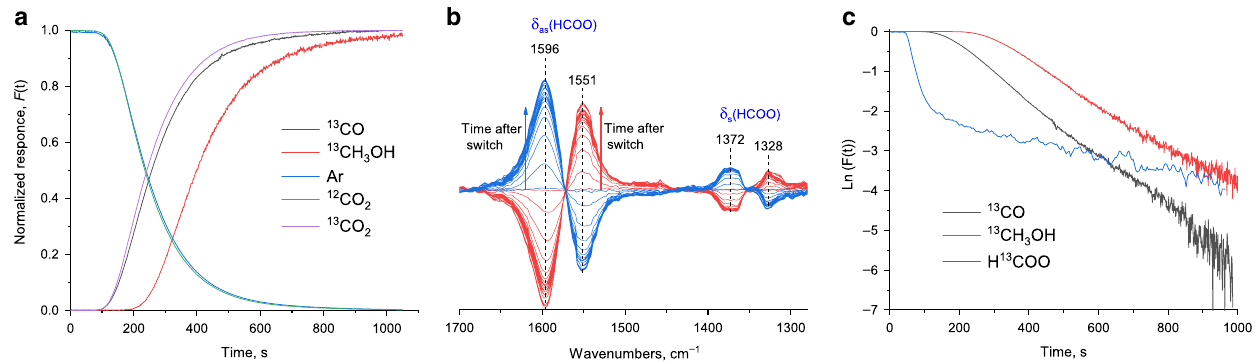
Fig. 1 Results of SSITKA-FTIR experiment. a Normalized isotopic transient response curves following the switch from 12 CO 2 /H 2 to 13 CO 2 /H 2 mixture with a total fl ow of 25 cm 3 min − 1 , H 2 /CO 2 molar ratio of 3 at 533 K and 15 bar during the reaction over CZA catalyst. b Time-resolved in situ FTIR difference spectra of surface species formed during switch from 12 CO 2 /H 2 to 13 CO 2 /H 2 (red spectra) and 13 CO 2 /H 2 to 12 CO 2 /H 2 (blue spectra) mixture at 533 K and 15 bar during the reaction over CZA catalyst. c Comparison of logarithmic transient responses of methanol, carbon monoxide and formate species from SSITKA-FTIR over CZA.